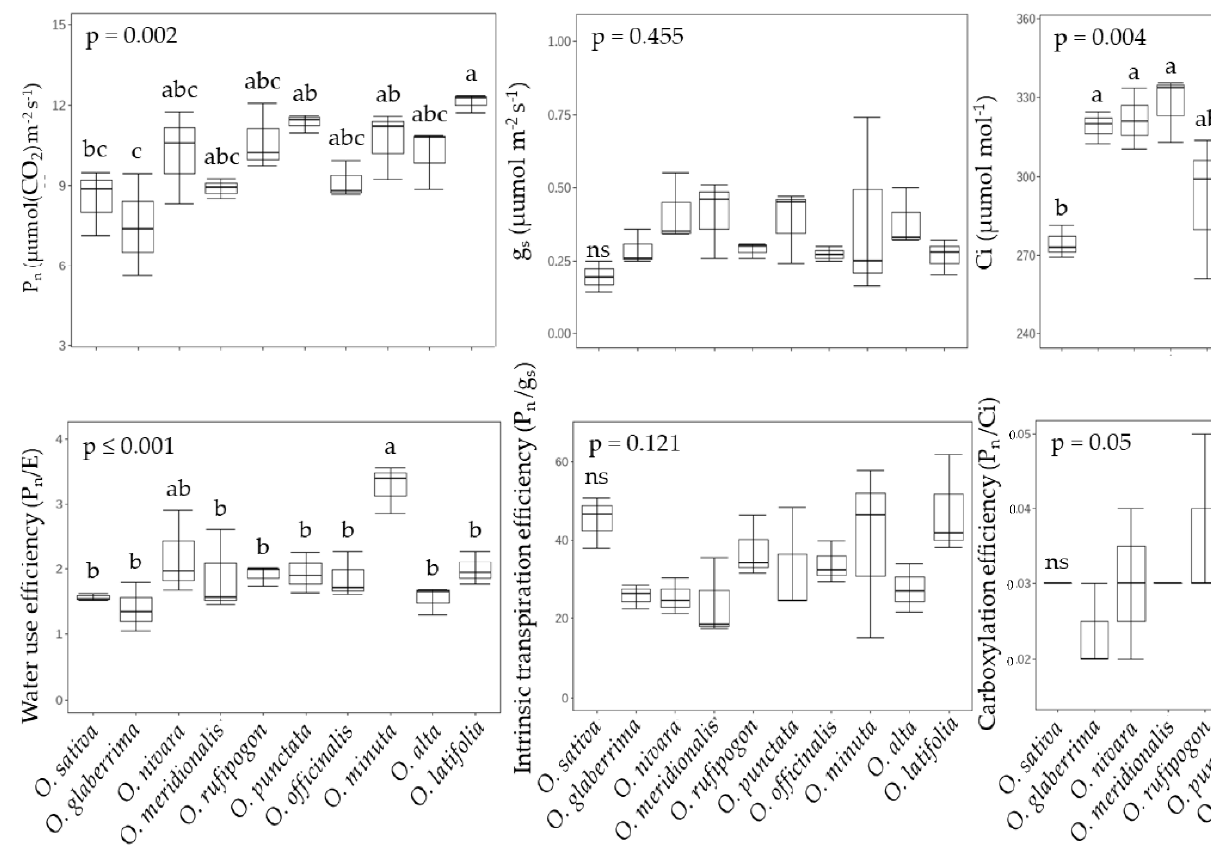
Figure 3. Variations in leaf photosynthetic characteristics water use efficiency (WUE) between wild rice species at 60 DAT (mean of three replications ± S.D.). P n —net photosynthetic rate ( µ mol (CO 2 ) m − 2 s − 1 ); g s —stomatal conductance ( µ mol (H 2 O) m − 2 s − 1 ); Ci —intercellular CO 2 concentration ( µ mol mol − 1 ); E —transpiration rate (mmol (H 2 O) m − 2 s − 1 ); WUE ( P N /E )—water use efficiency. Means followed by different letters in the same raw are significantly different at p < 0.05 according to Tukey’s HSD test.